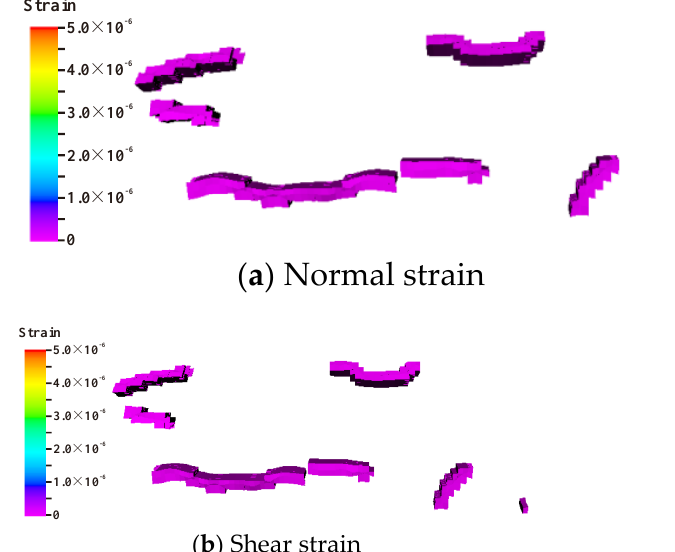
Figure 13. Plastic strain distribution of faults in the target formation.